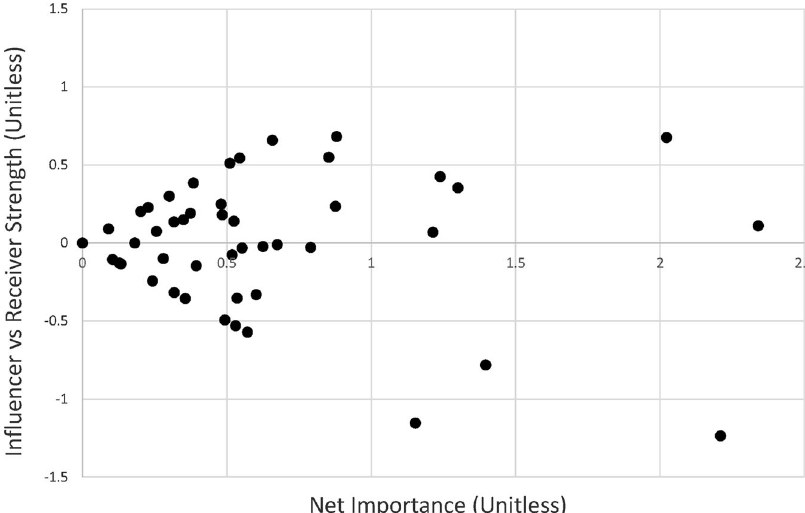
Fig. 2 DEMATEL analysis results indicating eight variable cut point. Each variable from the combined diagram is presented on the axes, according to net total importance ( x axis, unitless) and comparative strength as network in fl uencer vs receiver of in fl uence ( y axis, unitless). Eight variables are identi fi able as a cluster ranging from ~1.15 to ~2.35.